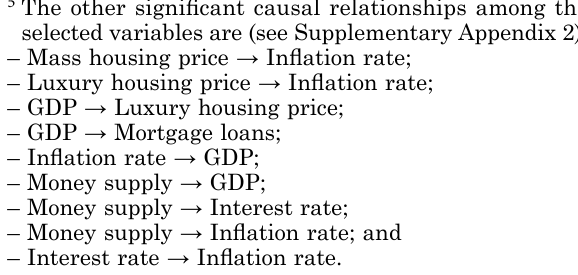
Fig. 9. Variance decomposition of outstanding residential